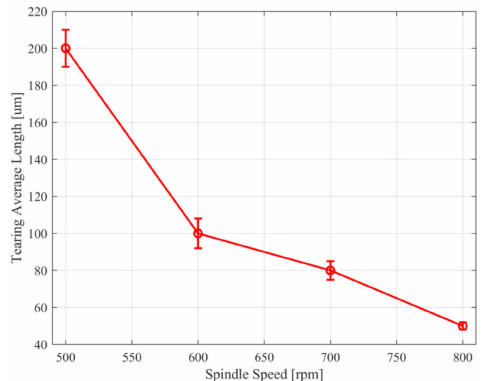
Figure 9. The effect of ultrasonic spindle speed on surface